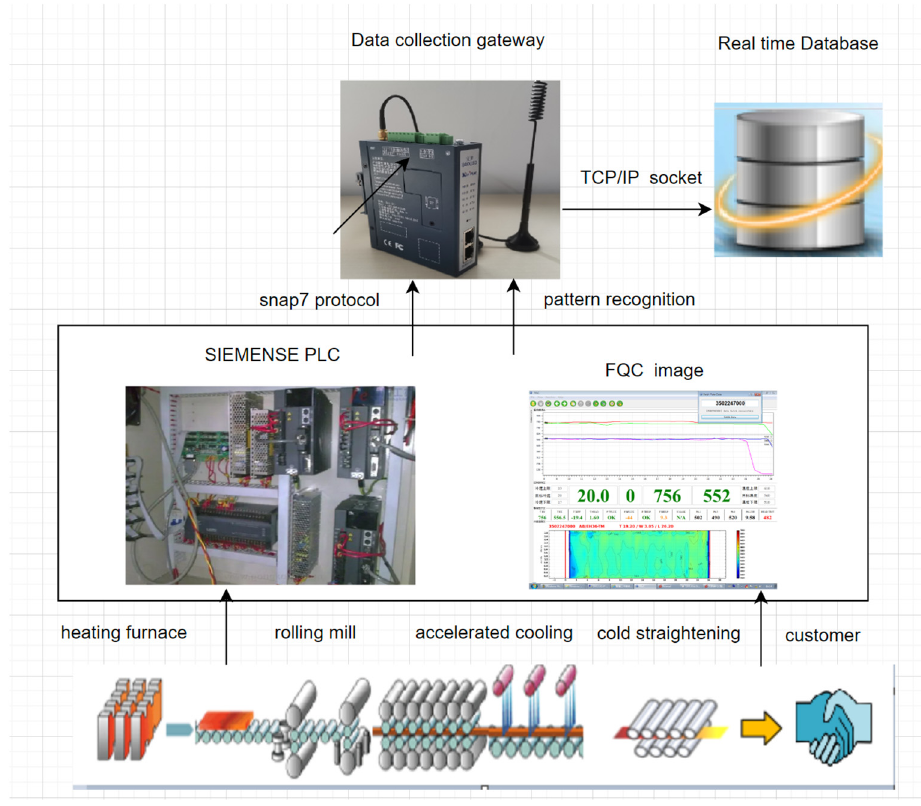
Figure 2. Dataset acquisition process.